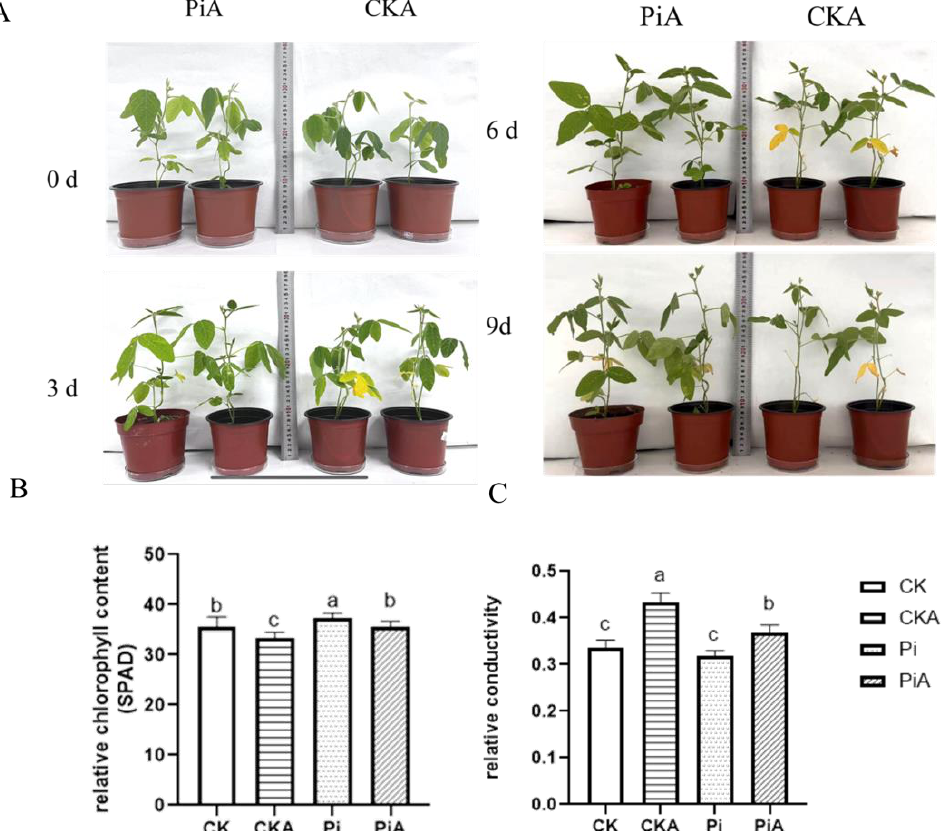
Figure 3. Effect of P. indica on the growth of the soybean ( A ), relative chlorophyll content ( B ), and relative conductivity ( C ) before and after salt treatment for nine days. CK: P. indica non-colonized control plants; Pi: plants inoculated with P. indica . CKA: Control plants were treated with 200 mmol/L NaCl. PiA: inoculated soybeans were treated with 200 mmol/L NaCl. Different letters above the bars indicate a significant difference ( p < 0.05) from CK (0 h) between the CK and Pi groups. Error bars represent SDs (n = 3).